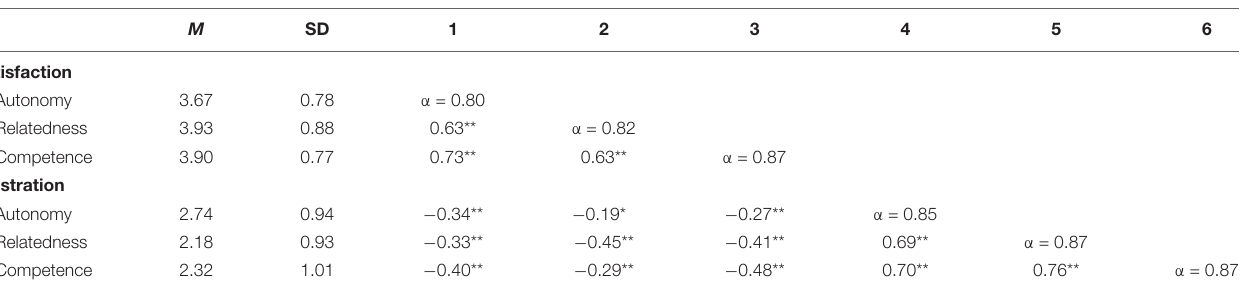
TABLE 2 | Means, standard deviations, reliabilities, and correlations of the Basic Psychological Needs, Study 1. M